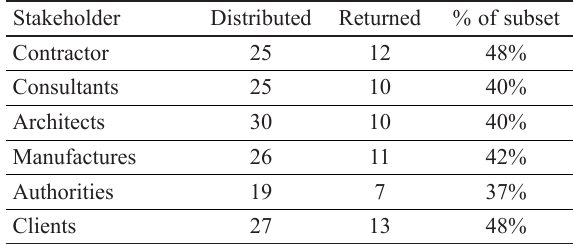
Table 2. Response rate per stakeholder